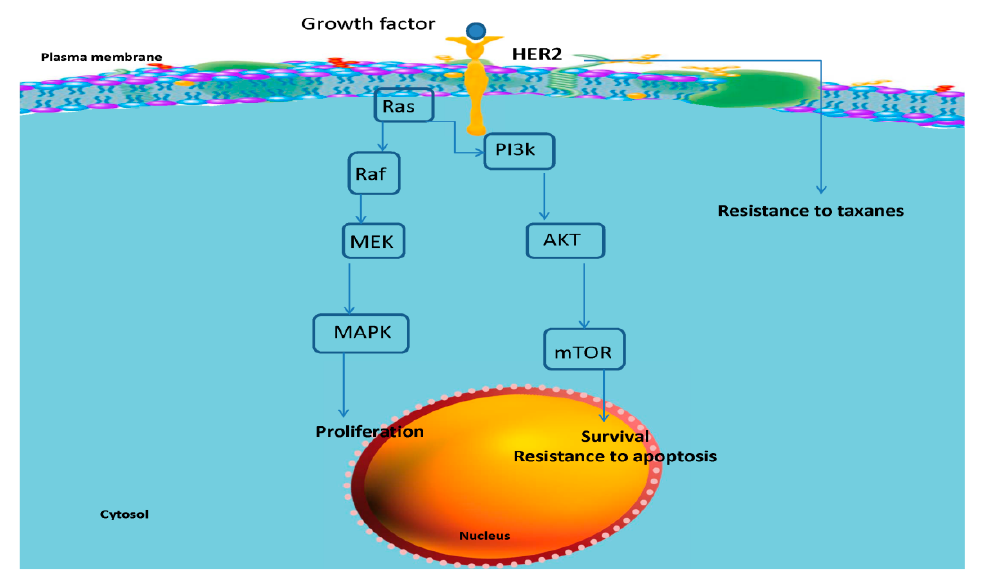
Figure 8. Summary of the ERBB2 and AKT signaling cascades regulating the cell’s proliferation, survival, and resistance to apoptosis and treatment.